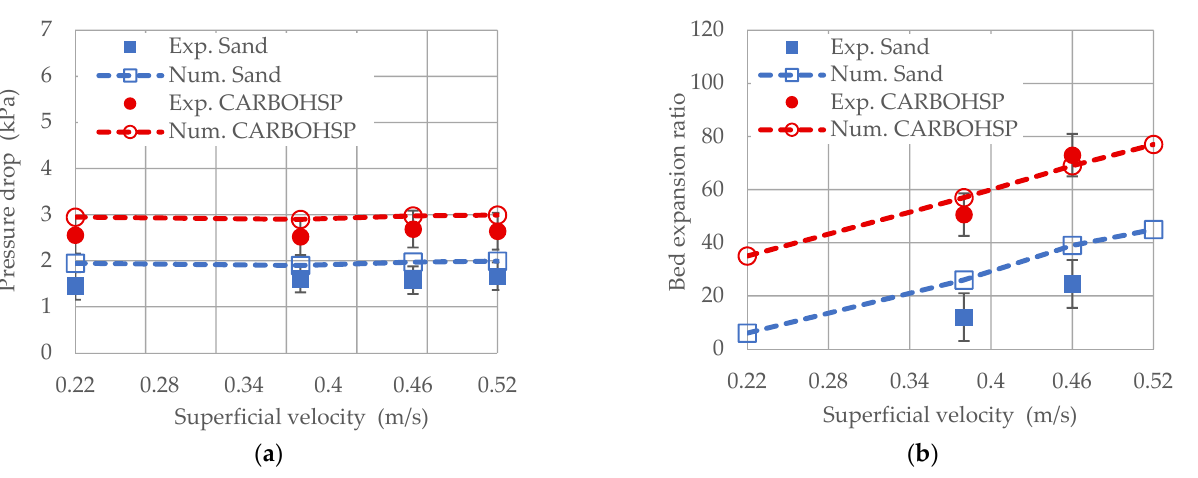
zation condition, beyond which it remains constant at greater velocities.